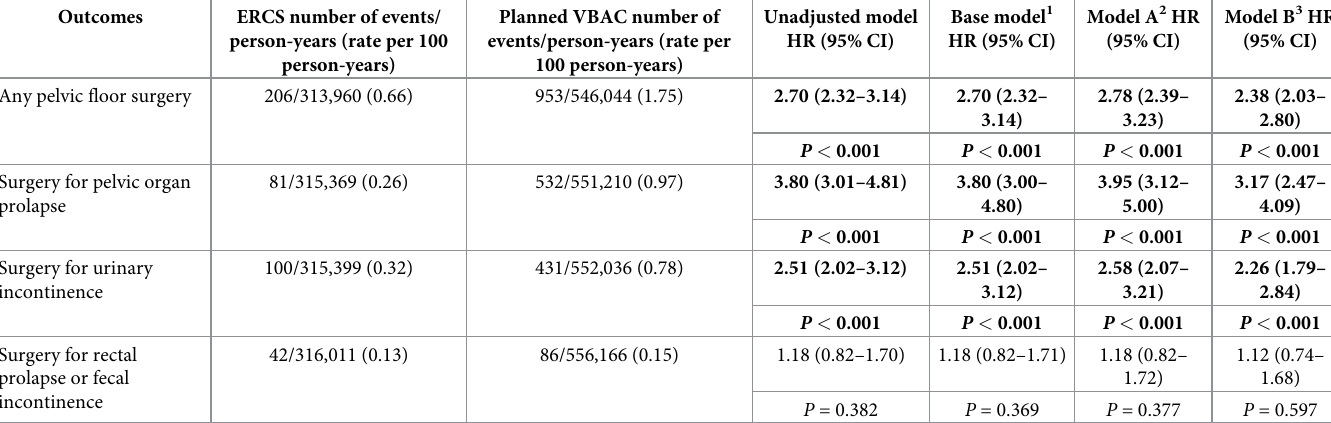
Table 2. Outcomes following planned VBAC compared to